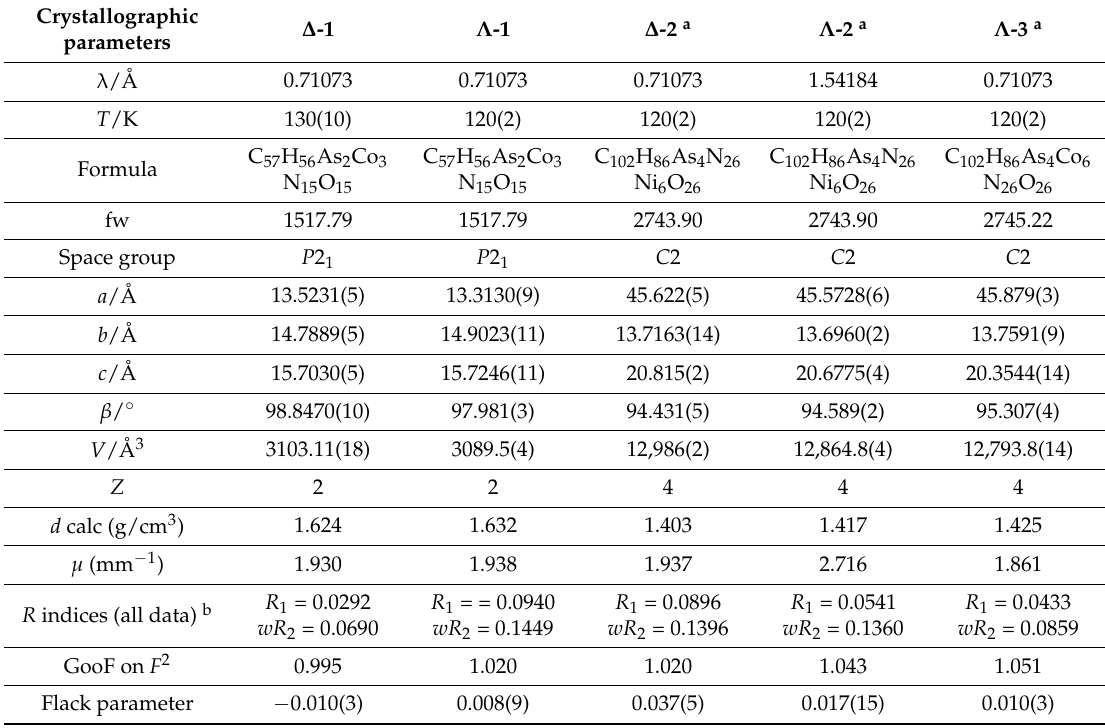
Table 1. Crystallographic data for complexes ∆ - 1 , Λ - 1 , ∆ - 2 , Λ - 2, and Λ - 3 .